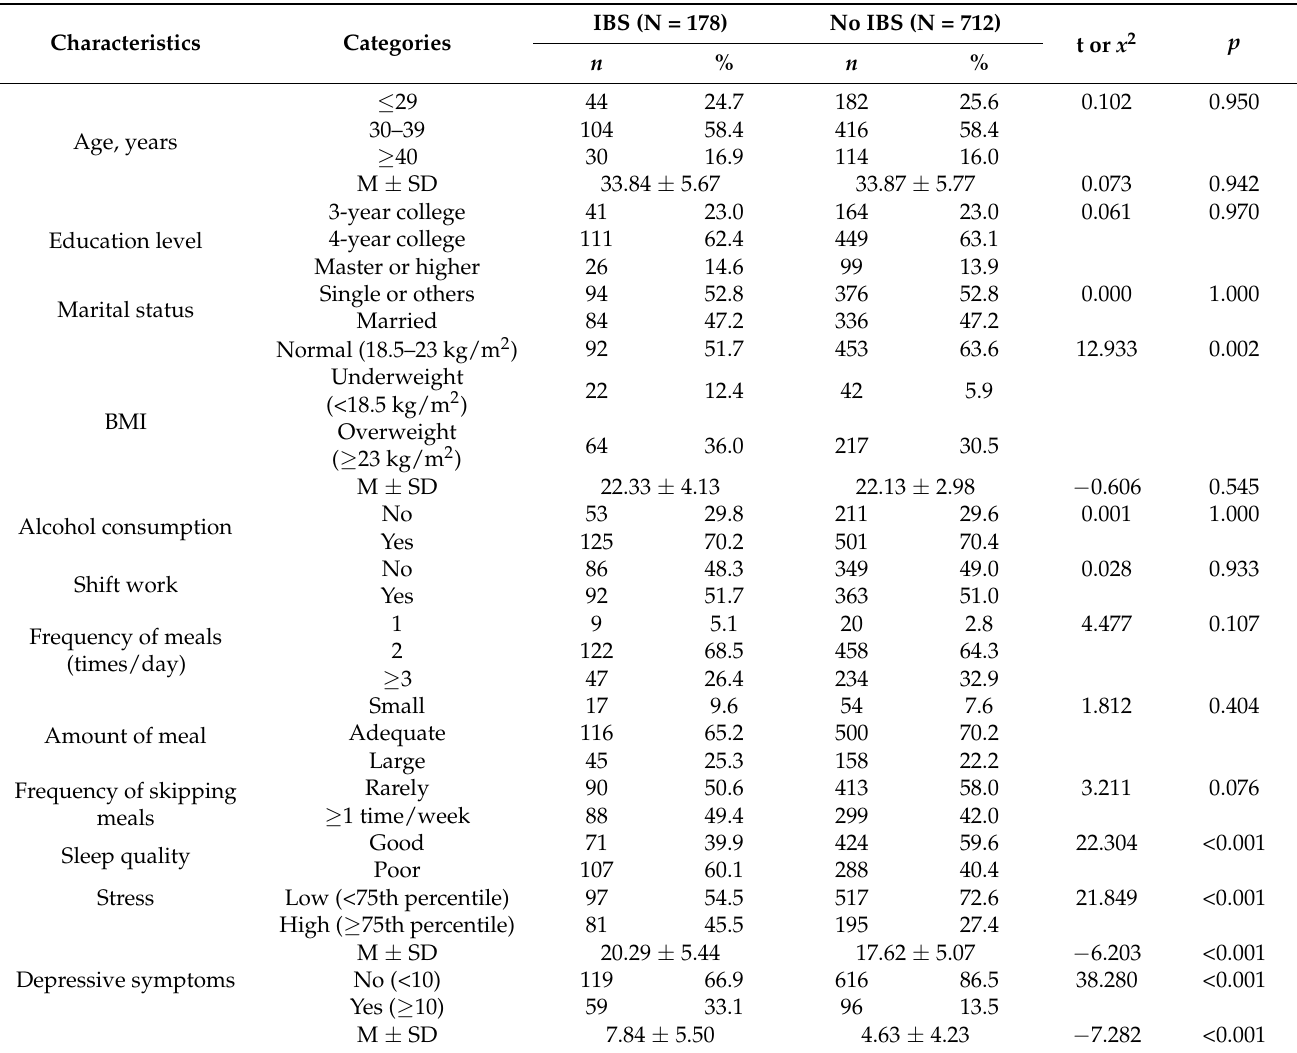
Table 2. Comparison between groups with and without irritable bowel syndrome (N =